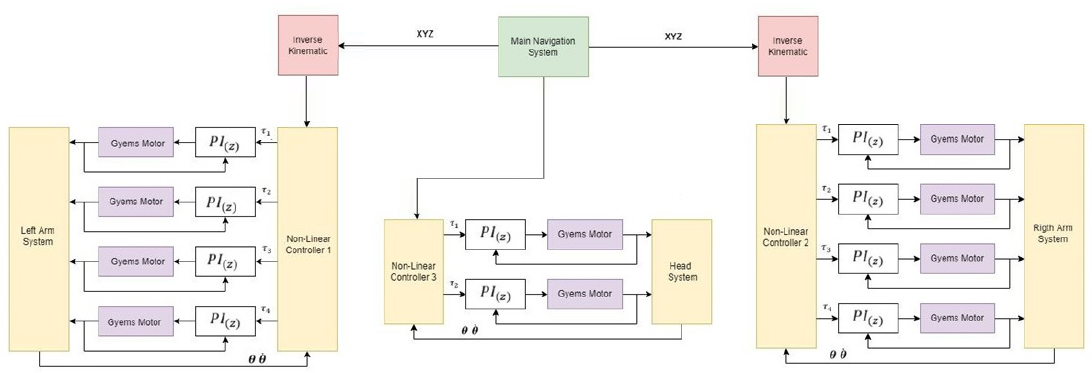
Figure 10. Proposed control scheme for the movements of the teleoperated